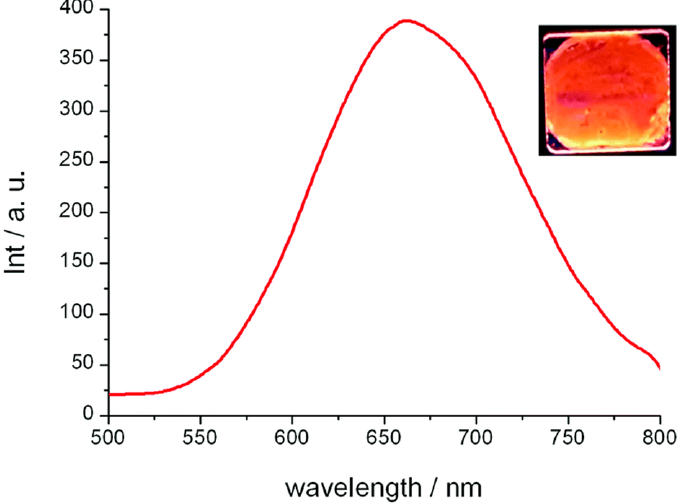
Figure 9. Photoluminescence spectrum in the columnar mesophase for 23a at 25 °C (excitation wavelength, 290 nm) and emission of the film observed under irradiation with a 254 nm handheld lamp (reproduced from ref. [58] with permission from the Royal Society of Chemistry).